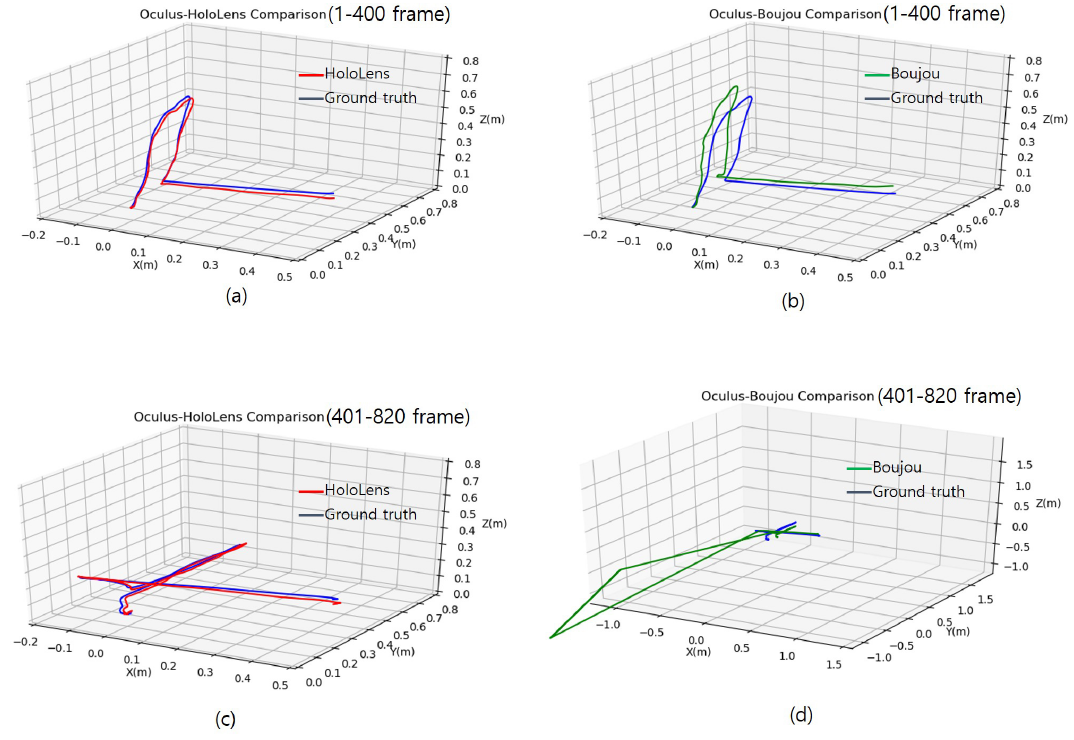
Figure 9. Accuracy evaluation of the camera trajectory extracted from HoloLens ( a , c ) and Boujou ( b , d ) method against ground truth (Oculus